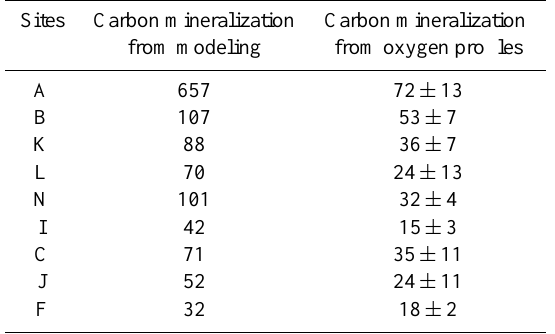
Table 5. Carbon mineralization rates as calculated from (1) model- ing and (2) in situ oxygen microprofiling. Units are gCm − 2 yr − 1 . Sites from